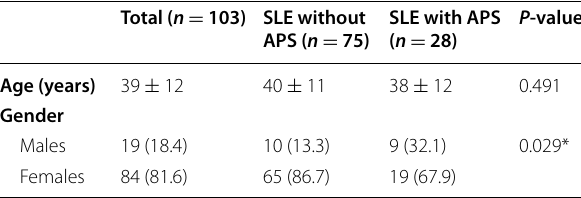
Table 1 Demographic characteristics of the studied